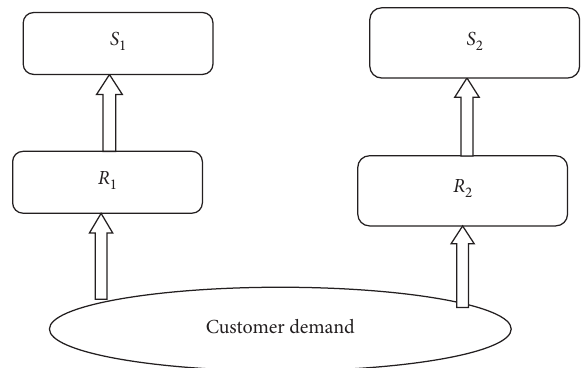
Figure 1: Theoretical model of the two-product and two-parallel supply chain